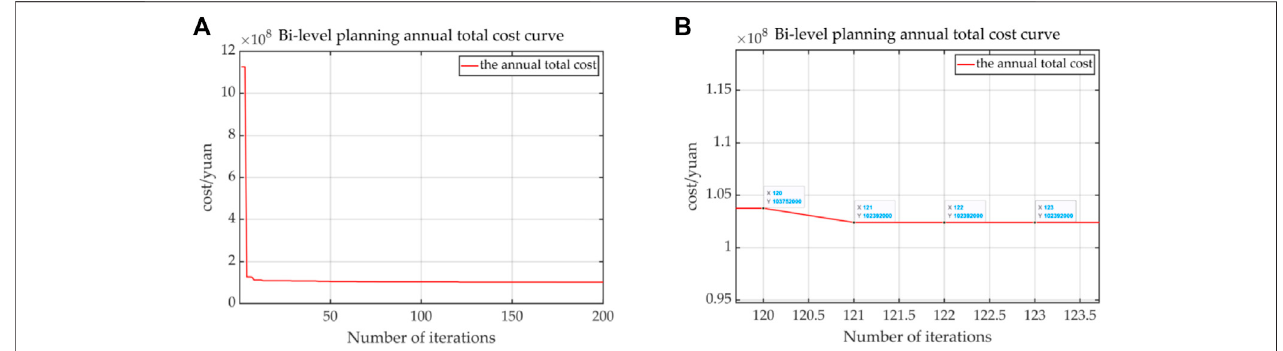
FIGURE11| Bi-levelplanningannual totalcost curve. (A) Overallconvergencecurveofthe annualtotal cost. (B) After120times ofconvergence, the convergence value is obtained.